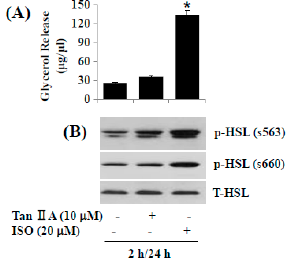
Figure 5. Effects of tanshinone IIA on lipolysis and hormone-sensitive lipase (HSL) phosphorylation in differentiated 3T3-L1 cells. ( A ) Differentiated 3T3-L1 cells were serum-starved for 2 h and treated with tanshinone IIA or isoproterenol (ISO) at the indicated concentration for additional 24 h. Glycerol contents were measured in triplicates. Data are mean ± SE of three independent experiments. * p < 0.05 vs. control; ( B ) Differentiated 3T3-L1 cells were serum-starved for 2 h and treated with tanshinone IIA or ISO at the indicated concentration for additional 24 h. Cellular protein was extracted and analyzed by Western blot analysis.